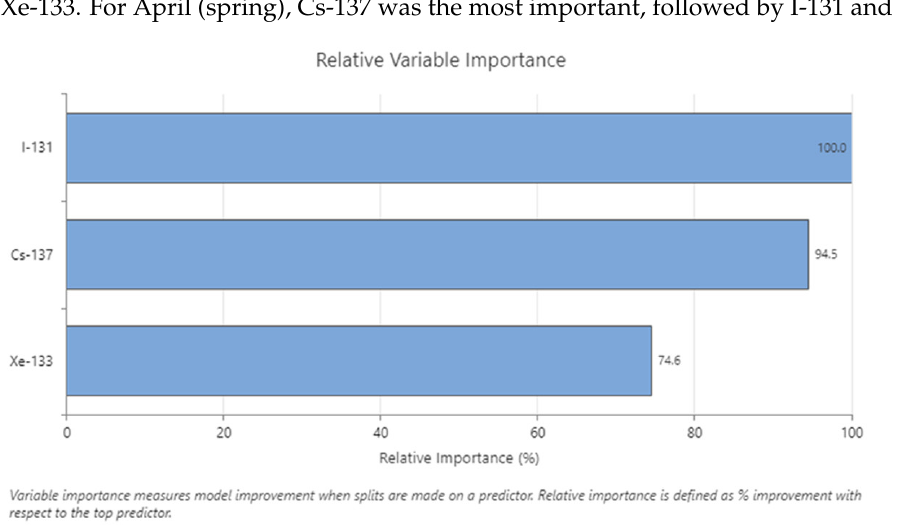
Figure 3. Graph showing relative importance of predictors in January (winter) . Figure 4. Graph showing relative importance of predictors April (spring) . Figure 5. The relative importance of predictors in October (fall) .